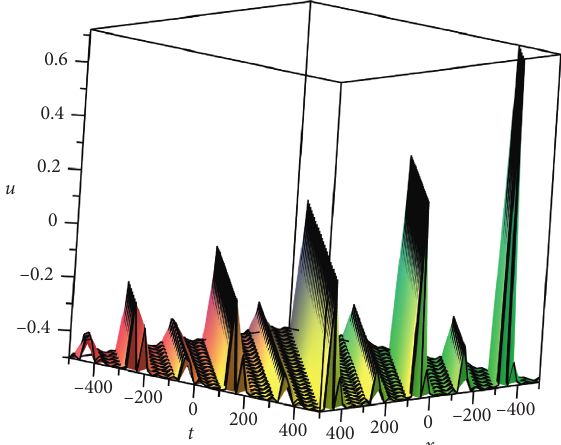
� √ , μ � 1 . 5 ,c � 1 , v � 0 . 001 , and C 2